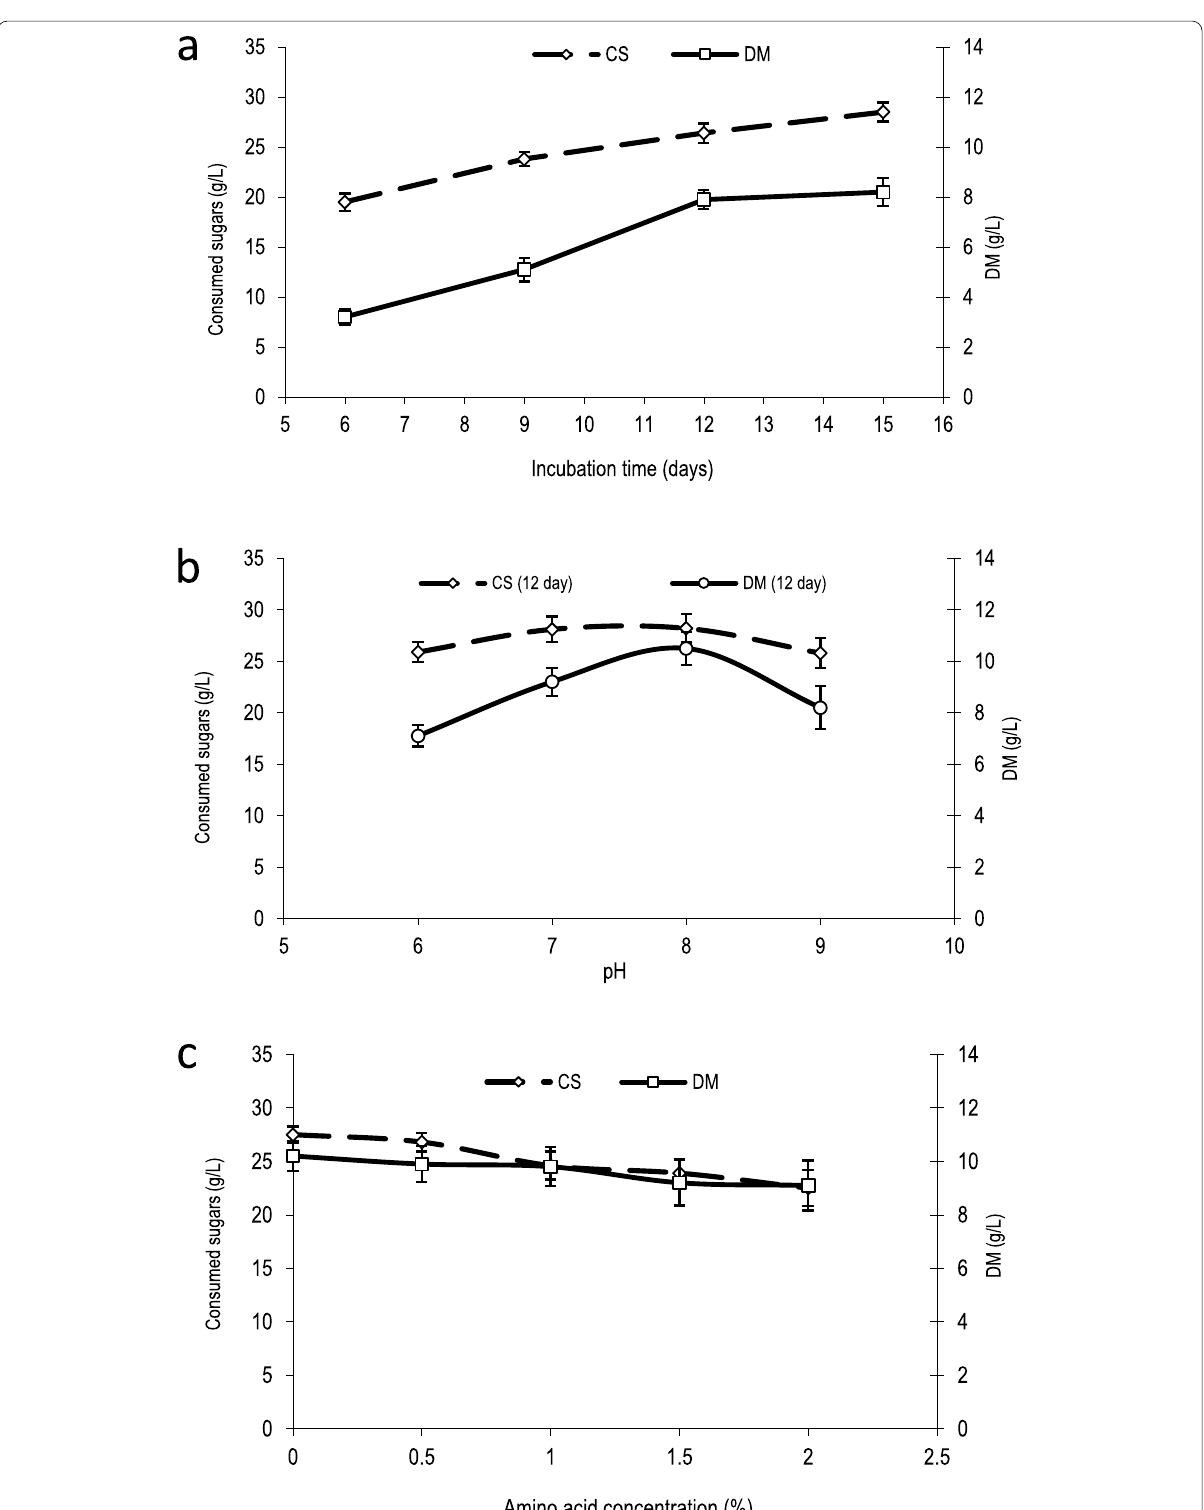
Fig. 2 Effect of incubation times, pH values and amino acids concentration on culture growth. a : Incubation times (6, 9, 12 and 15 days) at pH 7 without amino acids addition; b : pH values (6, 7, 8 and 9) for 12 days without amino acids addition; c : Amino acid concentrations (0.5, 1.0, 1.5 and 2) at pH 8 for 12 days ; CS: Consumed sugar, DM: Dry